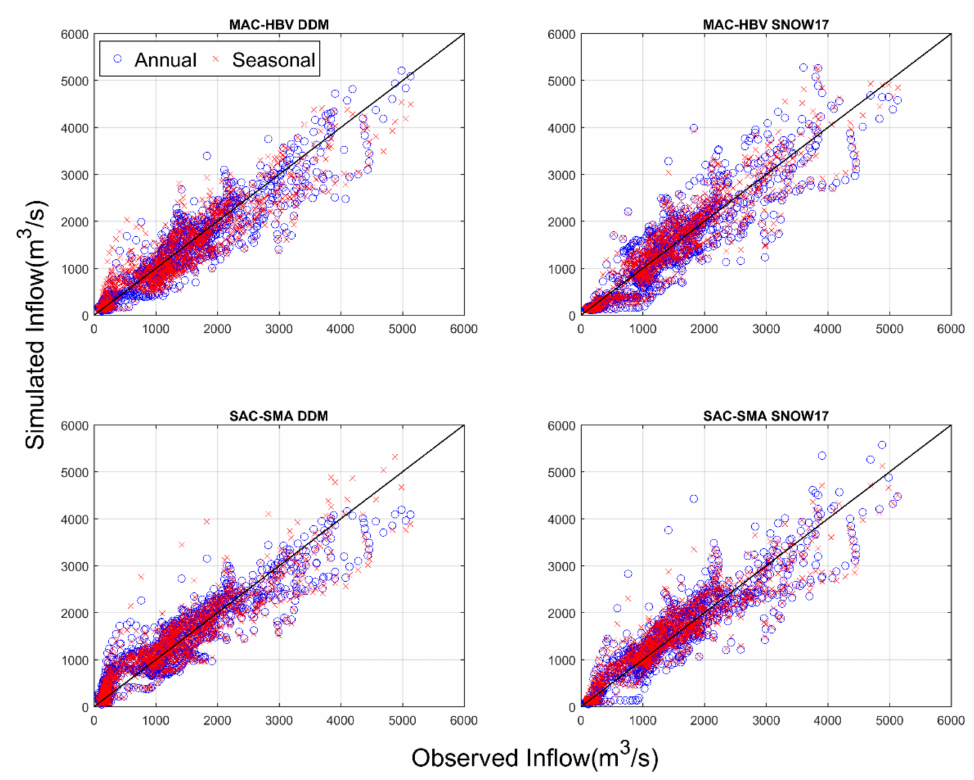
Figure 9. Validation scatterplots for the spring season at LGRB.